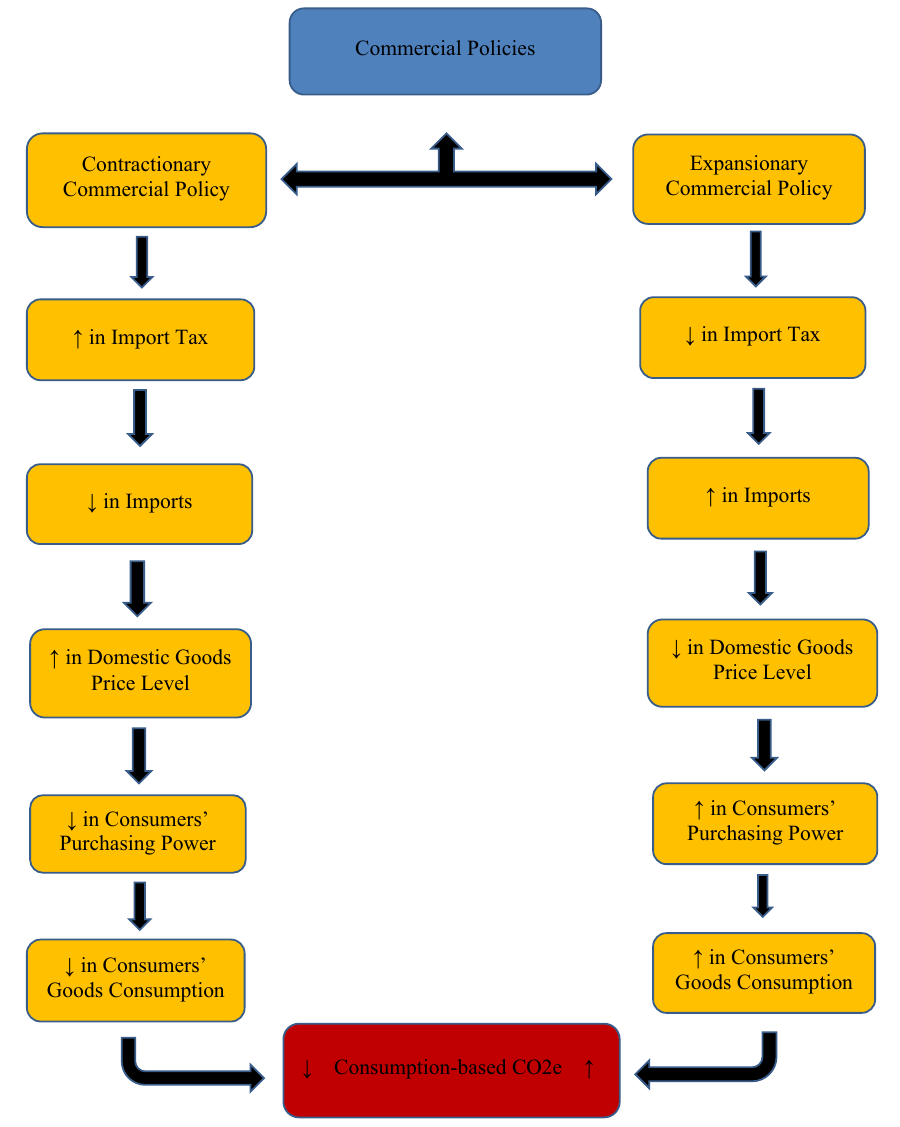
Fig. 5 Theoretical nexus between commercial policies and